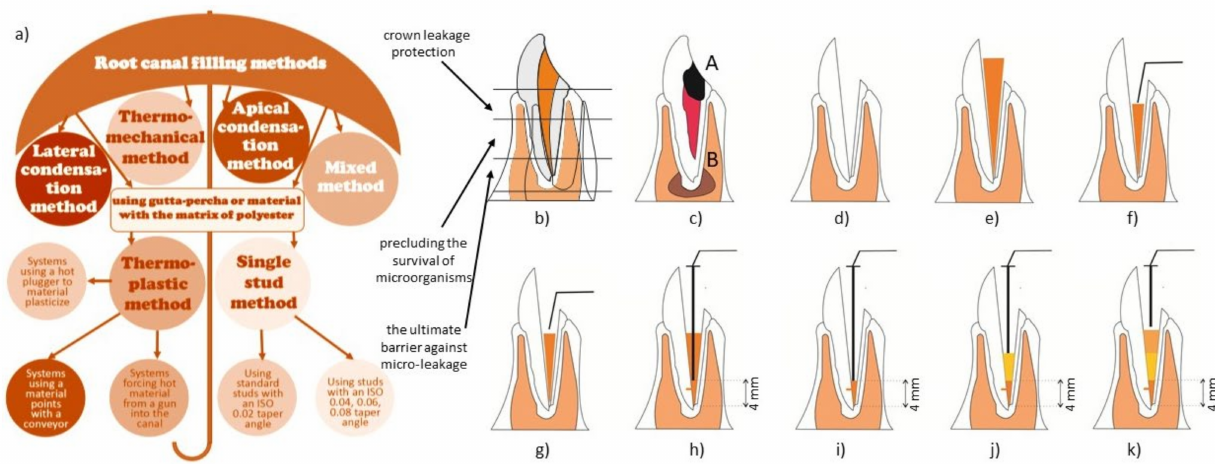
Figure 9. Scheme: ( a ) umbrella symbolically surrounding all types of root canal filling methods; ( b ) functions of filling the root canal; ( c ) dead pulp due to (A) a carious lesion with (B) a periapical lesion; ( d ) evacuation of the ventricular-root pulp and conical preparation of the root canal; ( e ) fitting the main cone to the root canal; ( f ) cutting off the main stud with a heated plugger; ( g ) condensation at the mouth of the severed main cone with a cold Buchanan plugger; ( h ) plasticizing the main stud by introducing the heated plugger to a depth 4 mm less than the working length and cutting off the excess stud; ( i ) condensation of the plasticized main cone with a cold Buchanan plugger; ( j ) filling 1/3 of the central part of the canal with liquid gutta-percha plasticized outside the canal and then condensation of the material with a cold Buchanan plugger as in ( i ); ( k ) final filling of the canal with liquid gutta-percha plasticized outside the canal and then condensation of the material with a cold Buchanan plugger as in point ( i